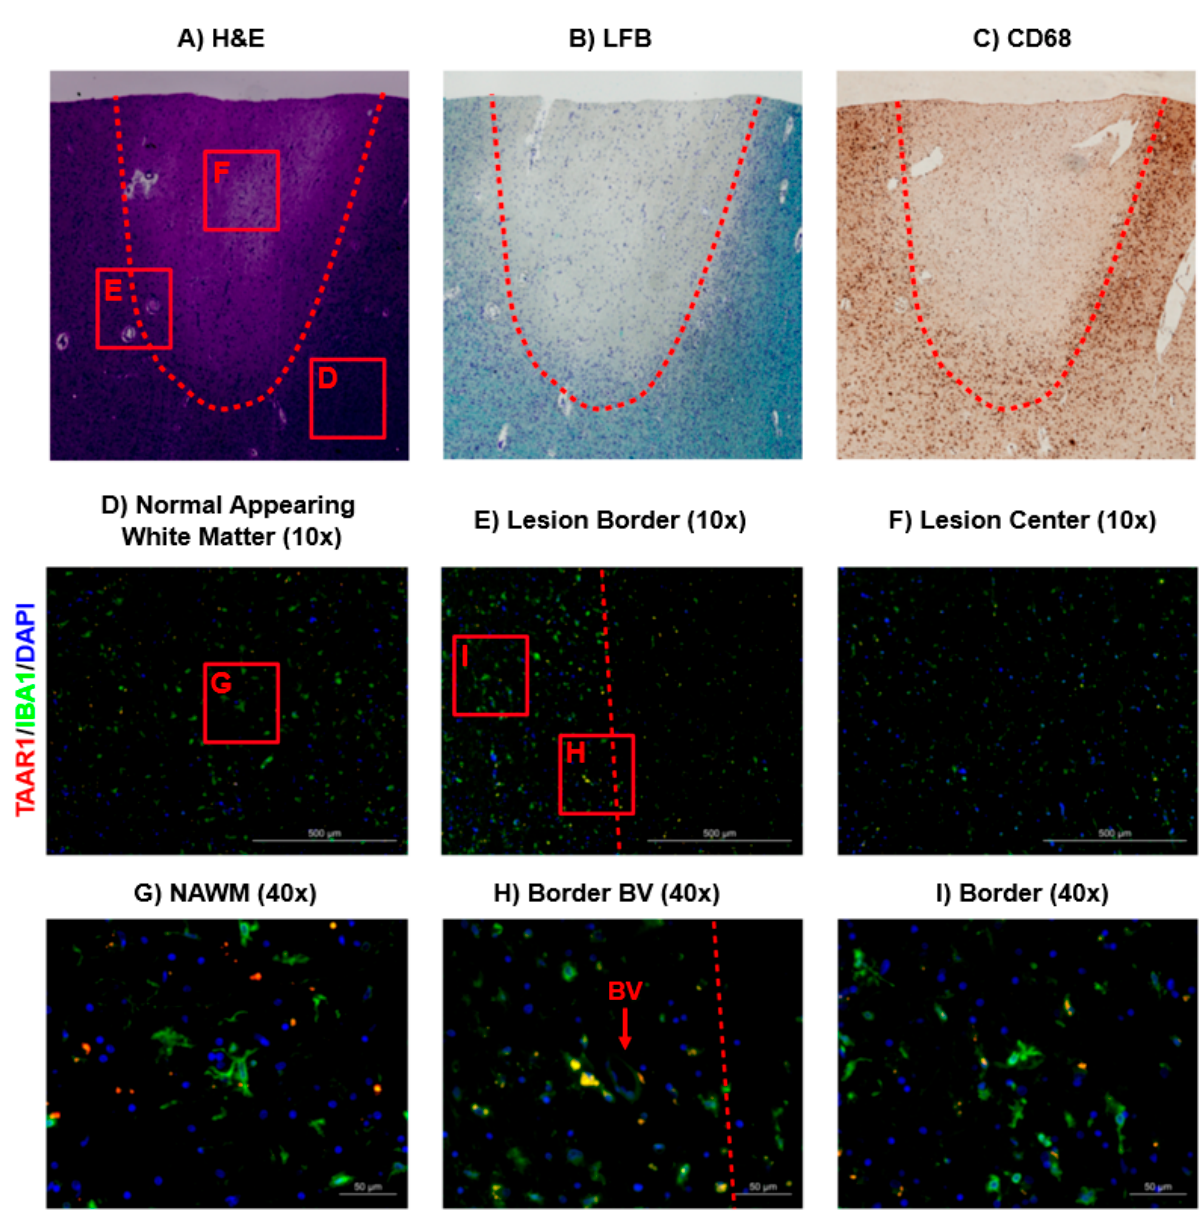
Figure 3. TAAR1 expression profile within and surrounding a mixed active/inactive MS lesion. Bright field images of a mixed active/inactive MS lesion were visualized using H&E ( A ), LFB ( B ), and CD68 ( C ) staining. Primary antibodies for TAAR1 and IBA-1 were used in combination with AlexaFluor™ 594(red) and AlexaFluor™ 647(green) conjugated secondary antibodies to visualize TAAR1 expression and microglia/macrophage localization, respectively ( D – I ). DAPI staining was used to identify nucleated cells (blue). Co-localization of IBA-1 and TAAR1 can be seen in yellow ( D – I ). Bright-field images were taken with the Cytation™ 5 Cell Imaging Multi-Mode Reader (BioTek). Fluorescent imaging was conducted with the Zeiss AX10 fluorescent microscope at 10× and 40× magnification and images generated in the built-in Zeiss software; Zen 2 Pro.